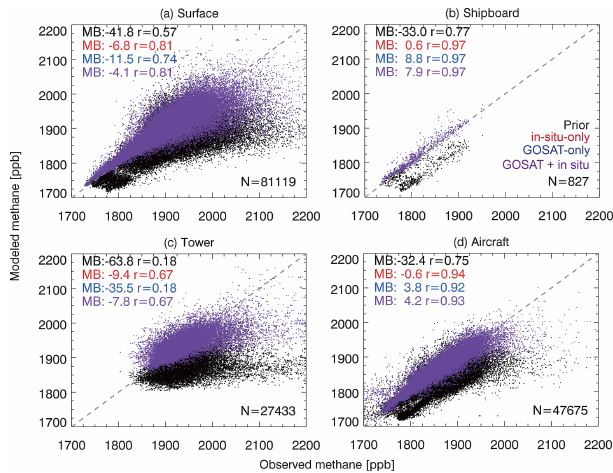
Figure 5. Ability of the inversions to fit the in situ methane obser- vations. Panels (a) – (d) compare the surface, tower, shipboard, and aircraft observations in 2010–2017 to the GEOS-Chem simulation using the prior (black) and posterior estimates of methane emis- sions and OH concentrations from the in-situ-only inversion (red, dots not shown), GOSAT-only inversion (blue, dots not shown), and GOSAT + in situ joint inversion (purple). The numbers ( N ) of ob- servations from each platform, the mean bias (MB), and the correla- tion coefficients ( r ) between the observed and simulated values are shown